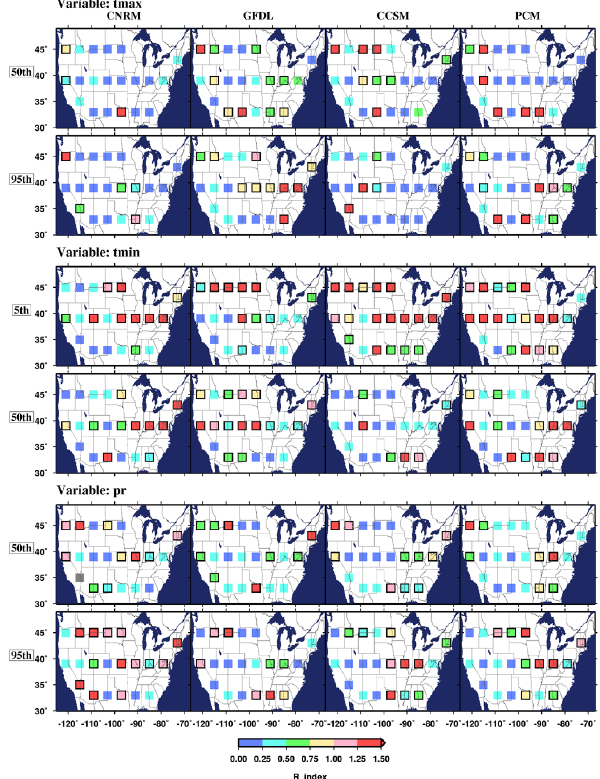
Fig. 6. R values for a 12yr base set and a 10yr projected set for Tmax, Tmin, and Pr for the 4 GCMs included in this study. As with Figs. 3–5, grid cells with dark outlines indicate where R values are not consistently less than 1 at 95%